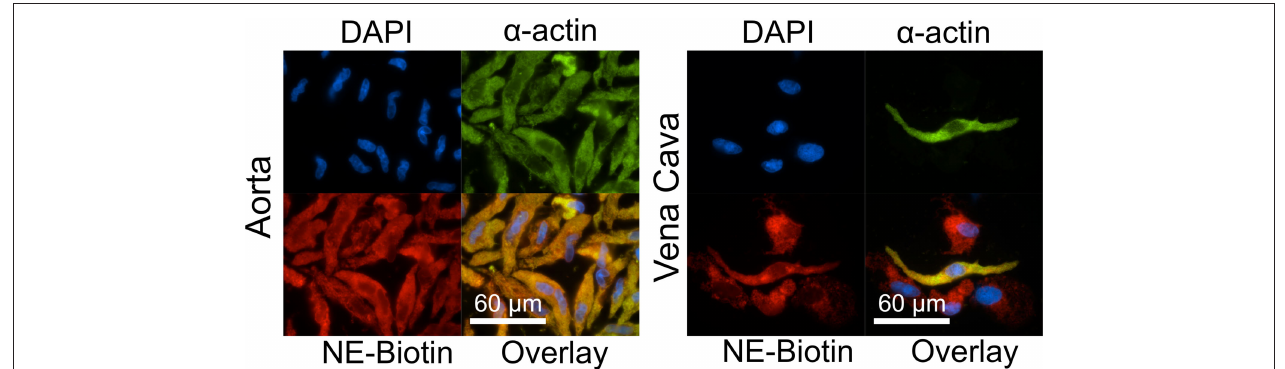
Figure 4 | Aorta and vena cava tissues can take up and attach Ne-biotin to proteins. Freshly dissociated smooth muscle cells of the aorta (left) and vena cava (right) were incubated with either 12.7 μM NE-biotin or vehicle (not shown) for 30 min. Staining with a Rhodamine-Red-X conjugated streptavidin (red,